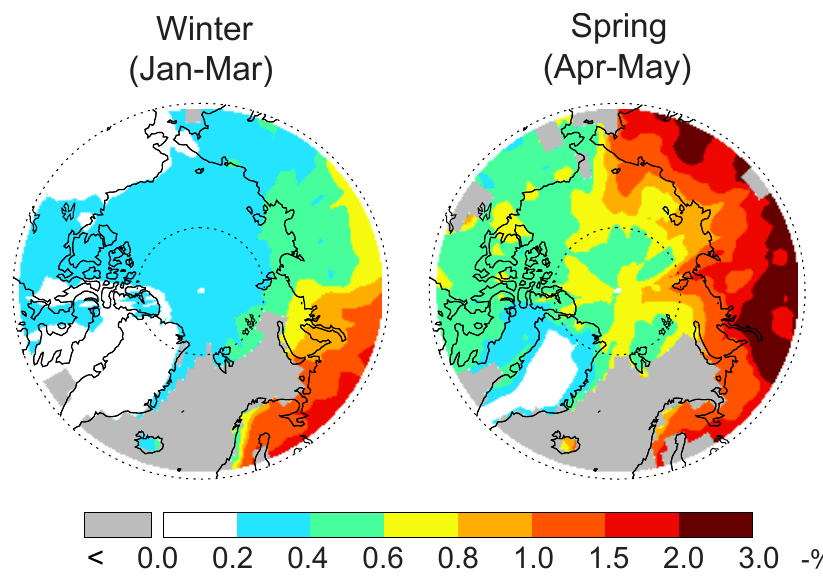
Fig. 14. Model decreases in snow albedo due to BC deposition in the Arctic ( > 60 ◦ N) in winter and spring 2008. Snow-free areas are shown in